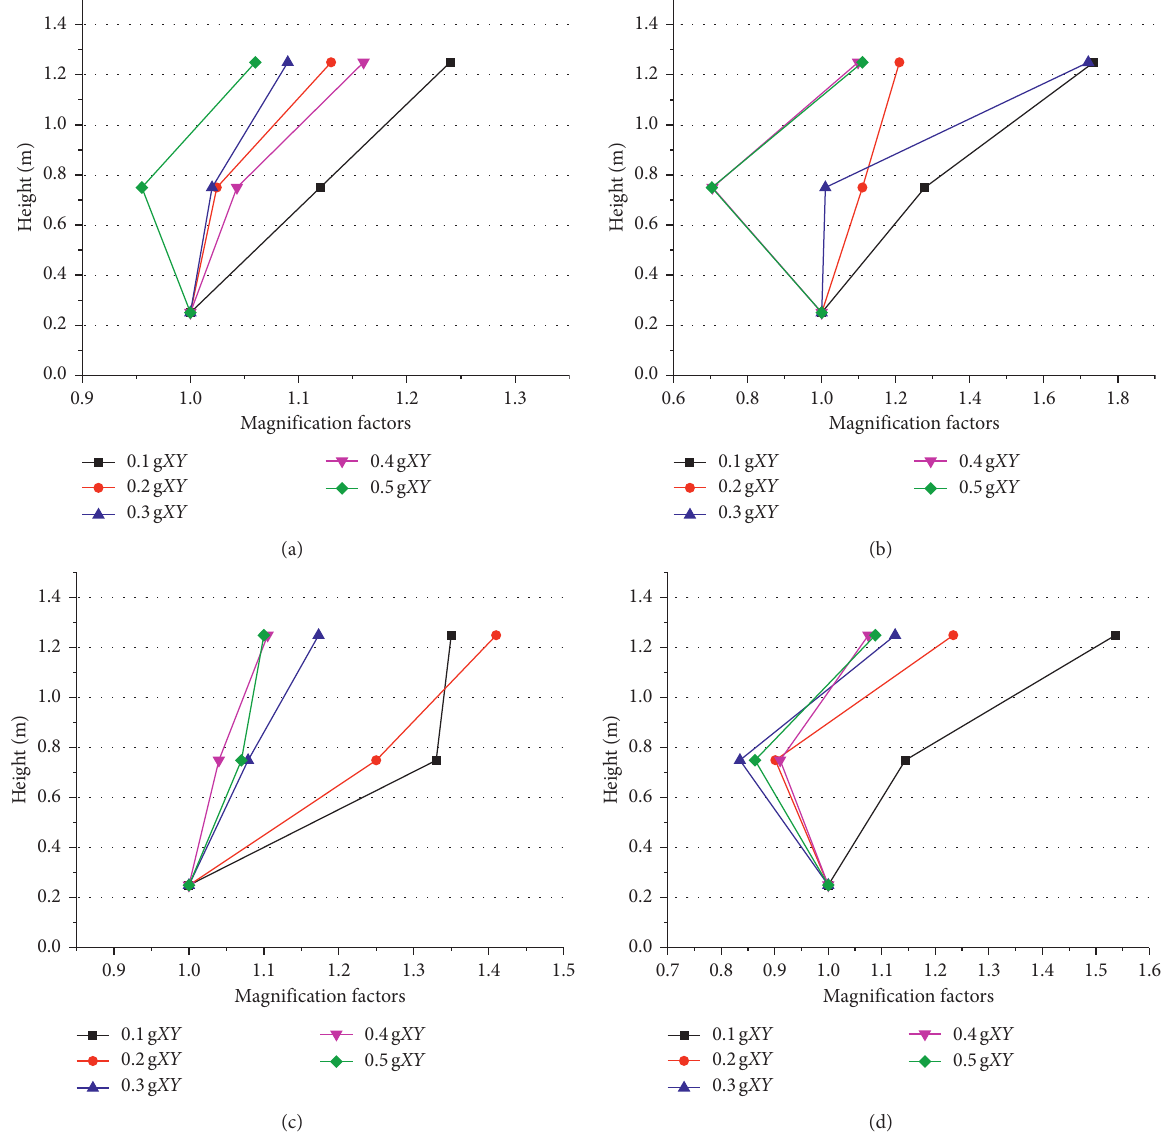
Figure 13: Acceleration magnification factors under the action of El Centro seismic wave. (a) Slope 1: flexible net wavy laying rein- forcement. (b) Slope 2: flexible net flat laying reinforcement. (c) Slope 3: barbed wire flat laying reinforcement. (d) Slope 6: flexible net wavy laying